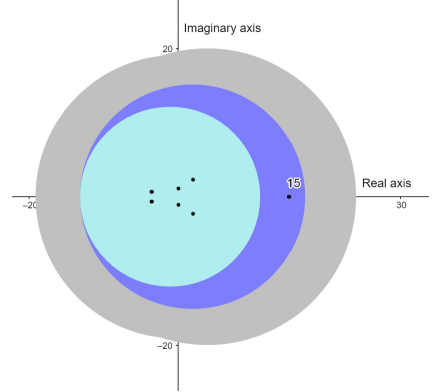
Figure 3: The area in turquoise is the region given by Theorem 3.3. For this particular example it is the same as the area given by Corollary 3.4. The Gershgorin region of the second typeof B T (given by Corollary 2.7) extends over the blue and turquoise areas. The original Gershgorin region of A T extends over the gray, blue and turquoise areas. The points in black represent the non-Perron eigenvalues of A . Observe that all of them are contained within the turquoise area given by Theorem